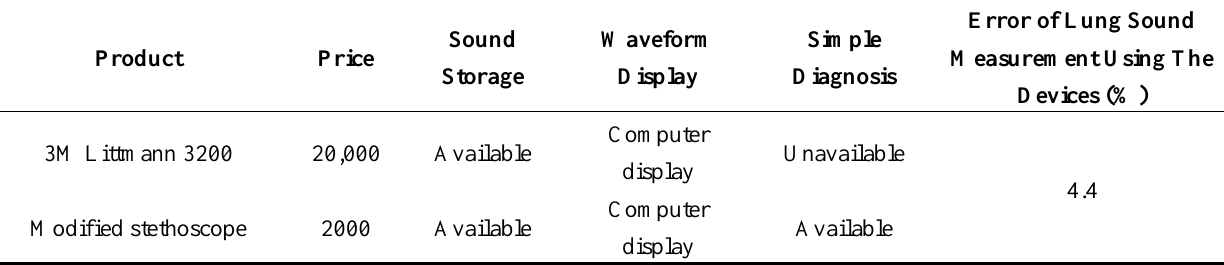
Table 9. Comparison of error between the two